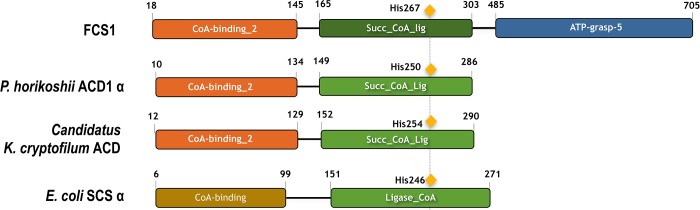
FCS1 domain architecture.FCS1 domain architecture compared against two closest homologues with defined structure from Pyrococcus horikoshii (2CSU); Candidatus Koracheaum cryptofilum (4XYL); and E. coli (1SCU_A), which is related protein succinyl-CoA synthetase, alpha chain. The conserved catalytic histidine residue is highlighted in the domain architecture. PFAM domains: CoA binding-2, PF13380 (E-value = 8e-23); succynil-CoA like ligase flavodoxin, PF13607 (E-value = 1e-40); ATP grasp_5, PF13549 (E-value = 9e-58).